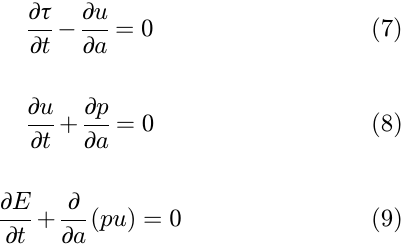
Fig. 14. “ Symmetric ” control. The colour code is from green (initially) to red ( fi nal